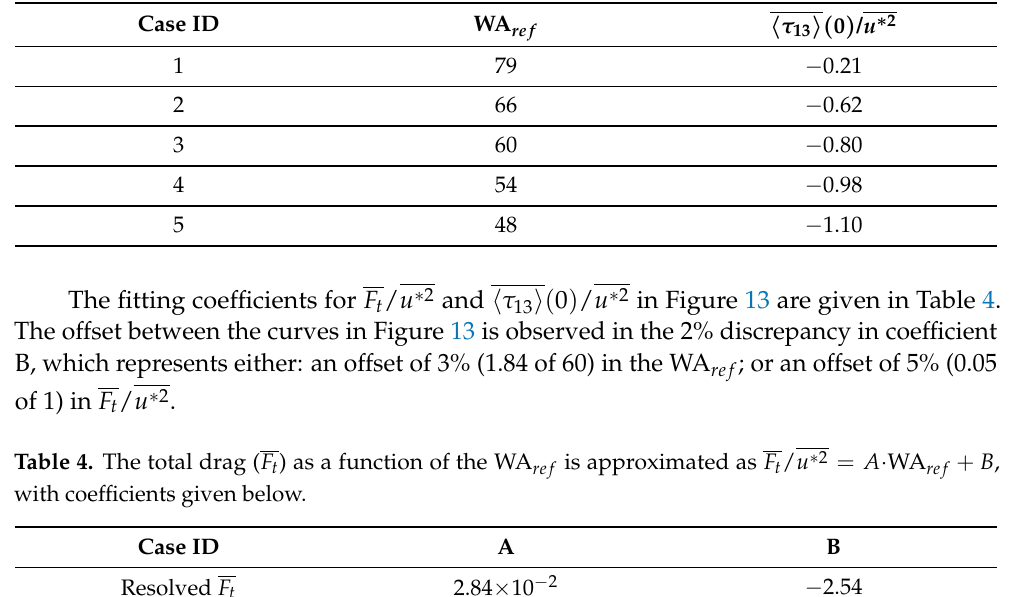
Table 3. Linear fitting for (cid:104) τ 13 (cid:105) ( z ) , from Figure 12. (cid:104) τ 13 (cid:105) ( z l ) = 0. The table gives the values of (cid:104) τ 13 (cid:105) ( 0 ) .